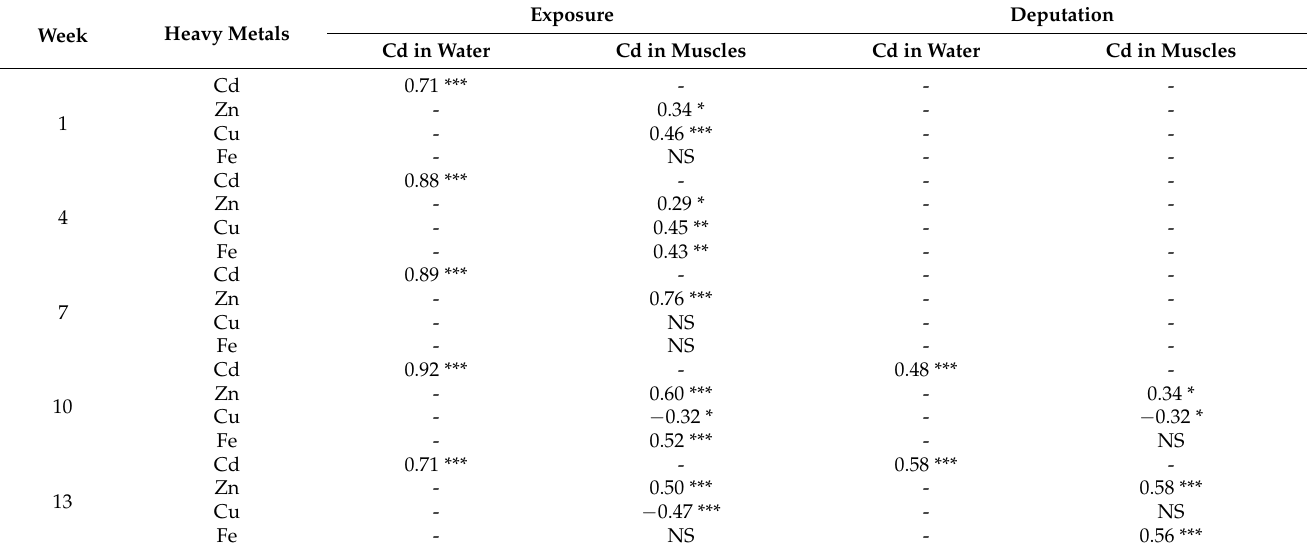
Table 4. Pearson’s correlation coefficients (r) for the relationship of cadmium concentration in muscles of fish and Cd dose in water as well as between Cd concentration in muscles and other heavy metals (Zn, Cu, Fe) level in muscles of the same fish, during the exposure and depuration periods, in consecutive weeks of the